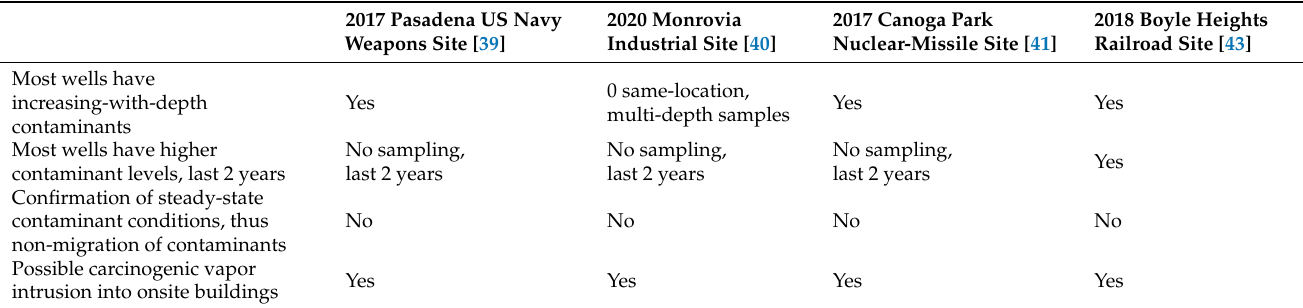
Table 6. Examples of steady-state contamination (RepQ10) in CBRE/TCC soil-gas assessments,